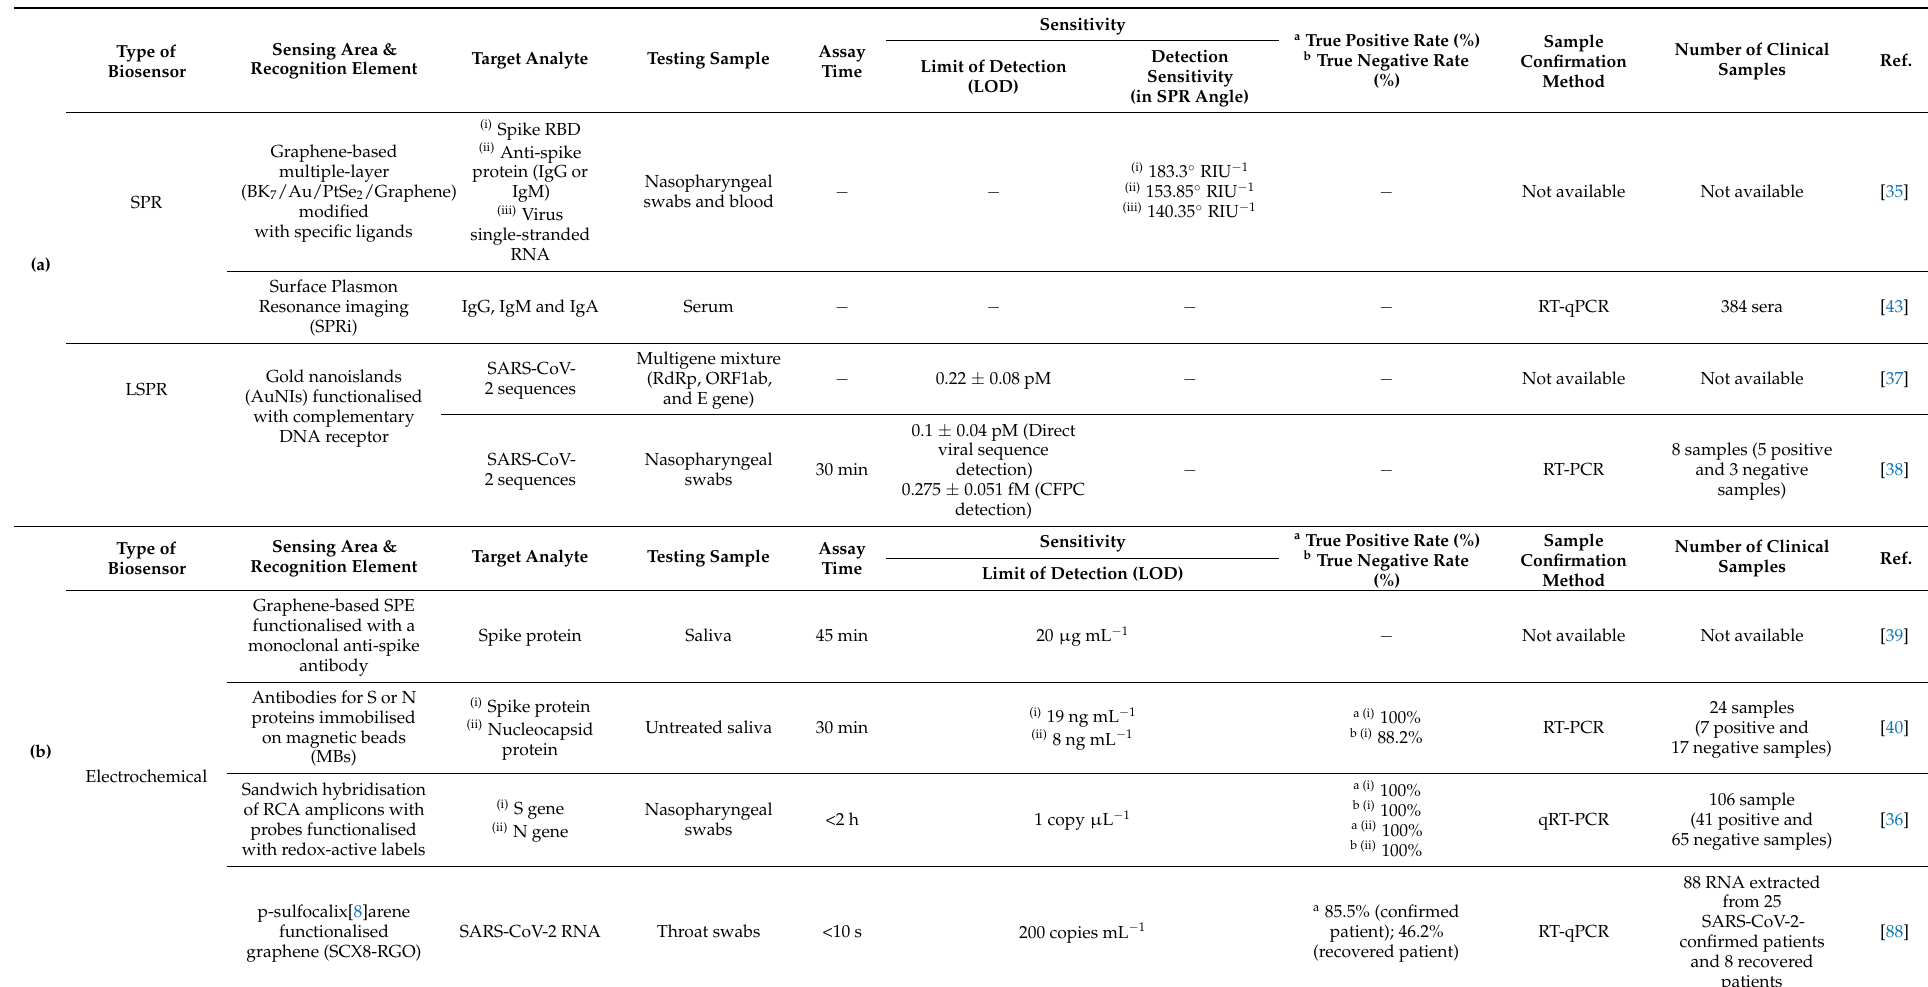
Table 1. Comparison of the latest developed biosensor: (a) SPR and LSPR, (b) Electrochemical and (c) FET for SARS-CoV-2 detection. In each row, (i), (ii), (iii) represent types of target analyte; 1, 2, 3 represent types of testing sample; a represents True Positive Rate (%) and b represents True Negative Rate